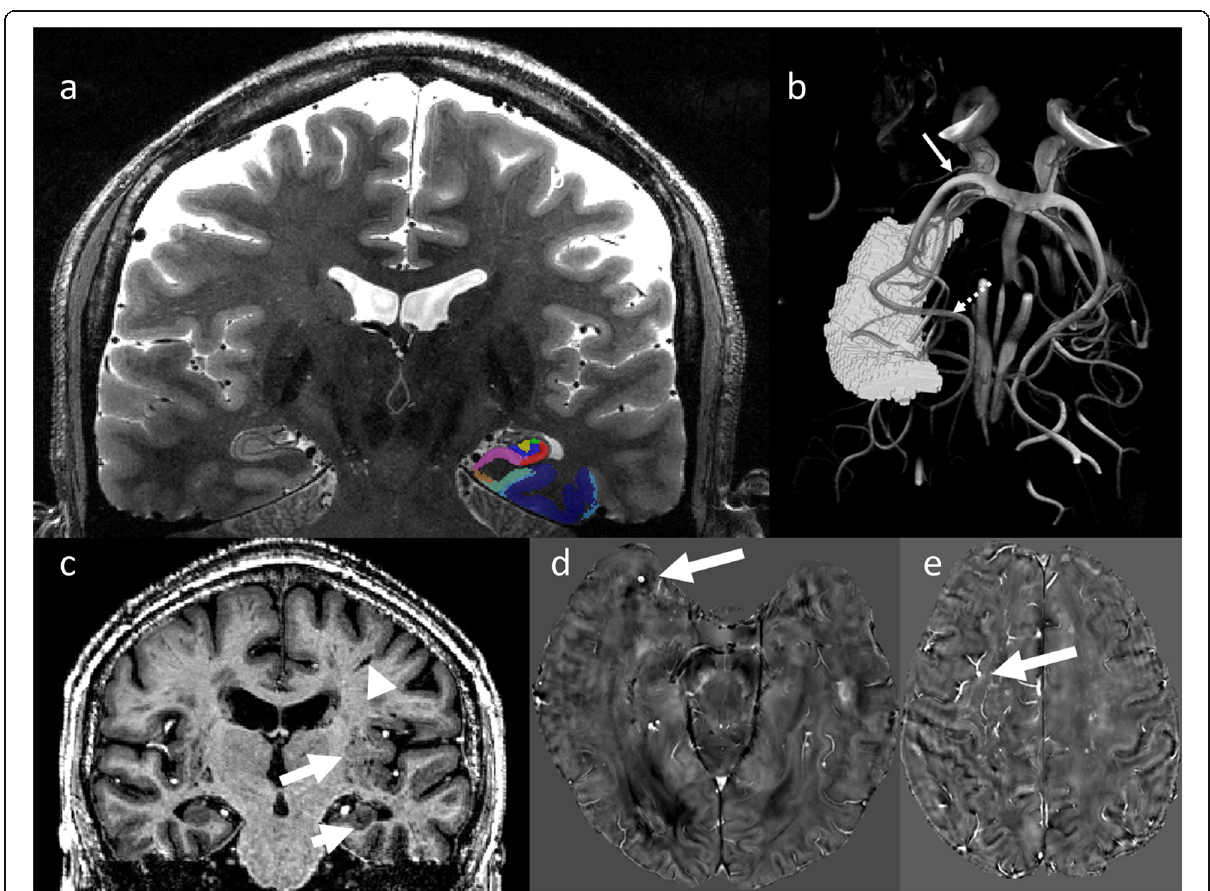
Fig. 1 Structural and vascular hippocampal and medial temporal lobe imaging at 7T in an older adult. a T2-weighted coronal 7-T MRI scan through the body of the hippocampus, immediately distal to the hippocampal head. Color legend of segmented regions: entorhinal cortex brown, Brodmann area 35 (transentorhinal) teal, Brodmann area 36 dark blue, subiculum mauve, CA1 red, CA2 green, CA3 yellow, dentate gyrus blue. b High-resolution time of flight imaging of hippocampal vascularization allowing to identify supplying vessels from the anterior choroidal artery (solid arrow) and the posterior cerebral artery (dashed arrow). c A structural T1-weighted coronal 7-T MRI in a patient with mild cognitive impairment and markedly enlarged perivascular spaces, particularly in the insular regions (long arrow) but also in the hippocampus (middle arrow). The scan also shows linear perivascular spaces alongside vessels (short arrow). d A microbleed in the anterior temporal lobe (white arrow) in a patient with cerebral amyloid angiopathy imaged with QSM at 7T. e A microbleed with a venous connection, as visualized with a QSM based